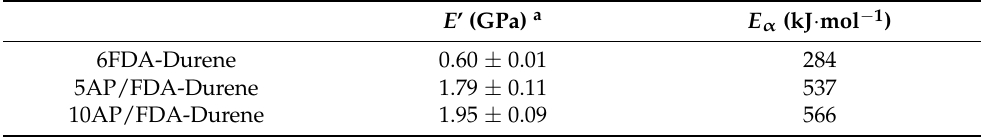
Table 3. Storage modulus ( E ’) and activation energies ( E α